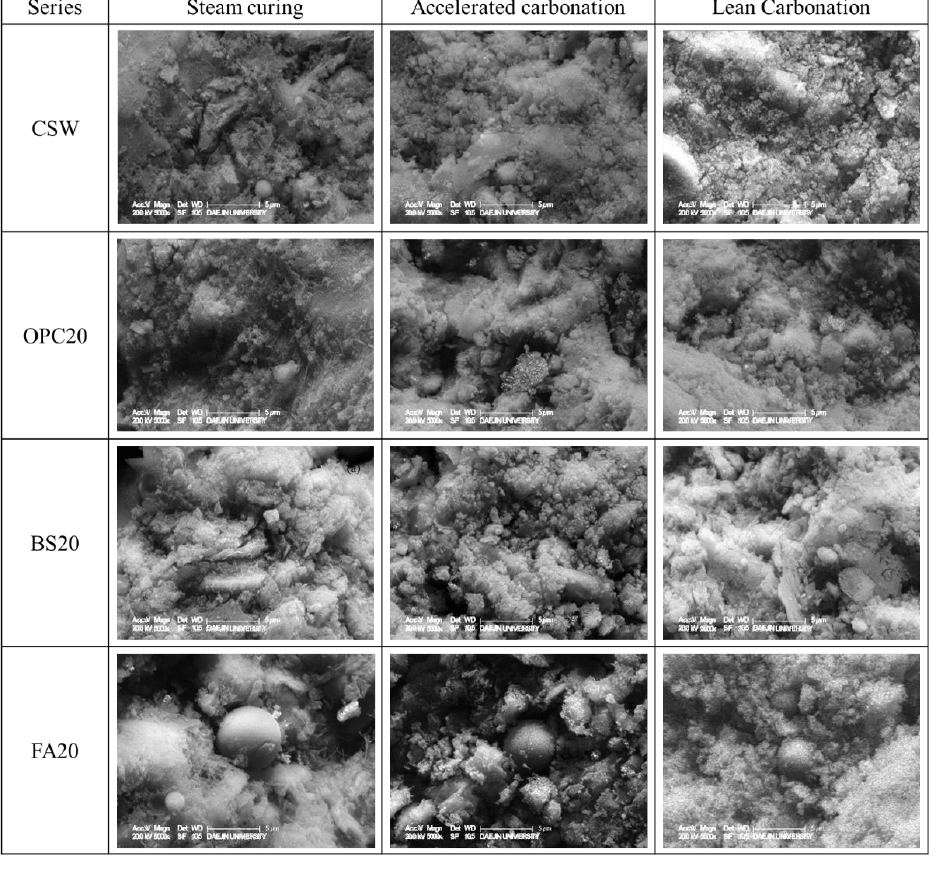
Figure 18. Scanning electron microscopy results (×5000).